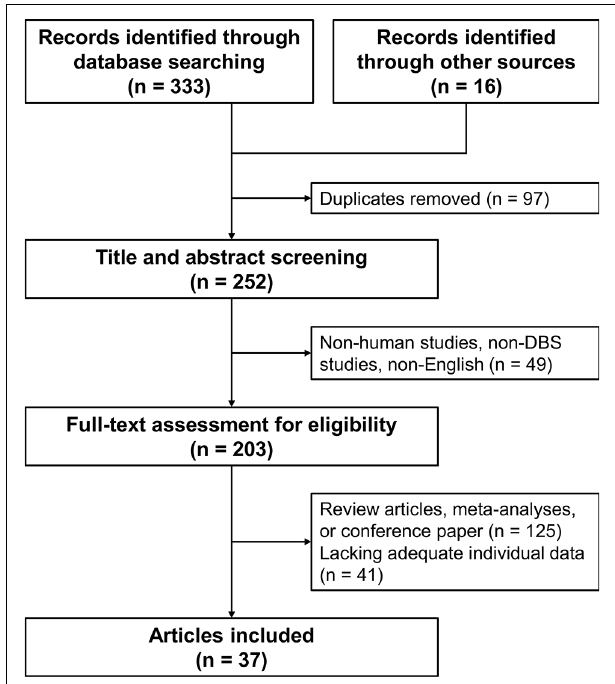
FIGURE 2 | Flowchart of the literature search.